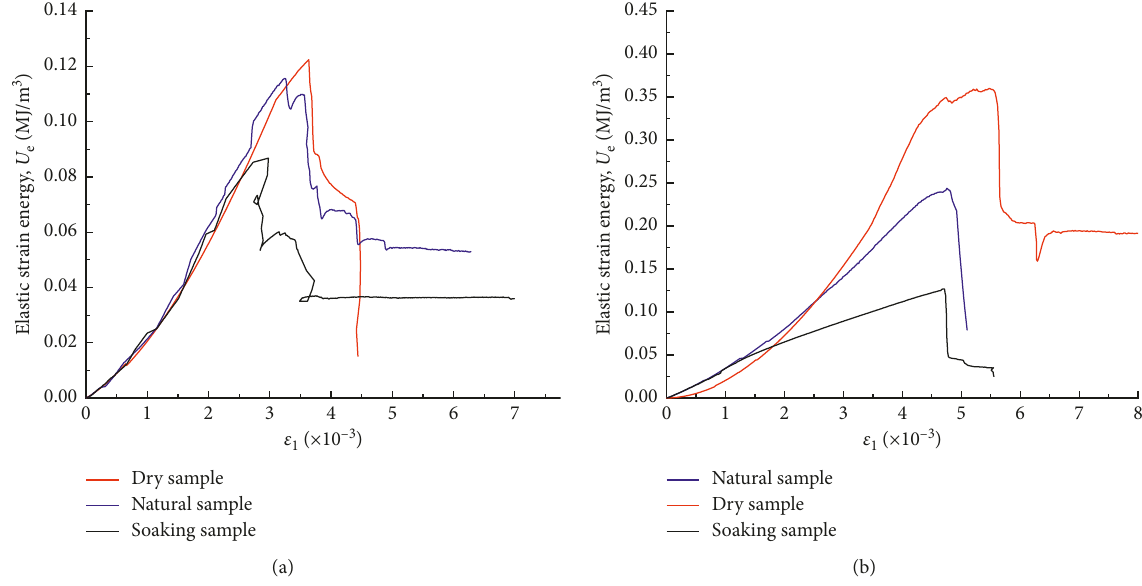
Figure 7: Relation curves of elastic strain energy with strain under different confining pressures. (a) 20MPa. (b)